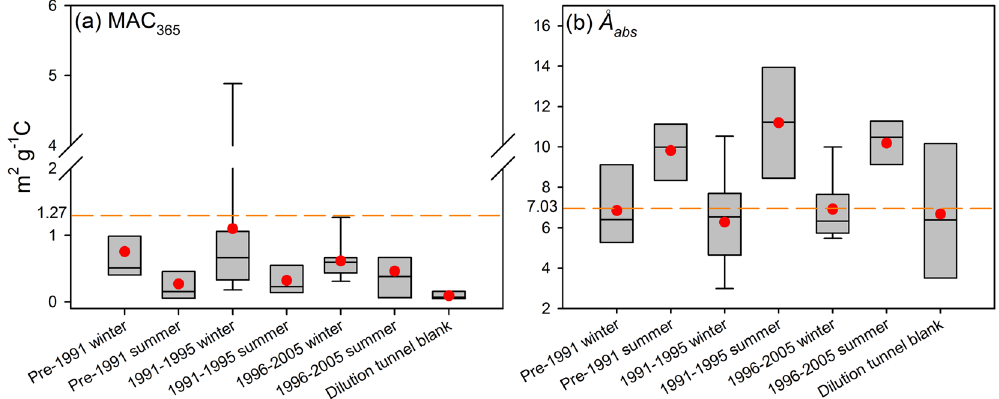
Figure 4. Seasonal box plots for ( a ) MAC 365 and ( b ) Å abs for different model year vehicles emissions. The boxes depict the median (dark line in the box), inner quartile range (gray box), 10 th and 90 th percentiles (whiskers) and the average (red circle). The orange dash lines represent the average MAC 365 and Å abs for biomass burning